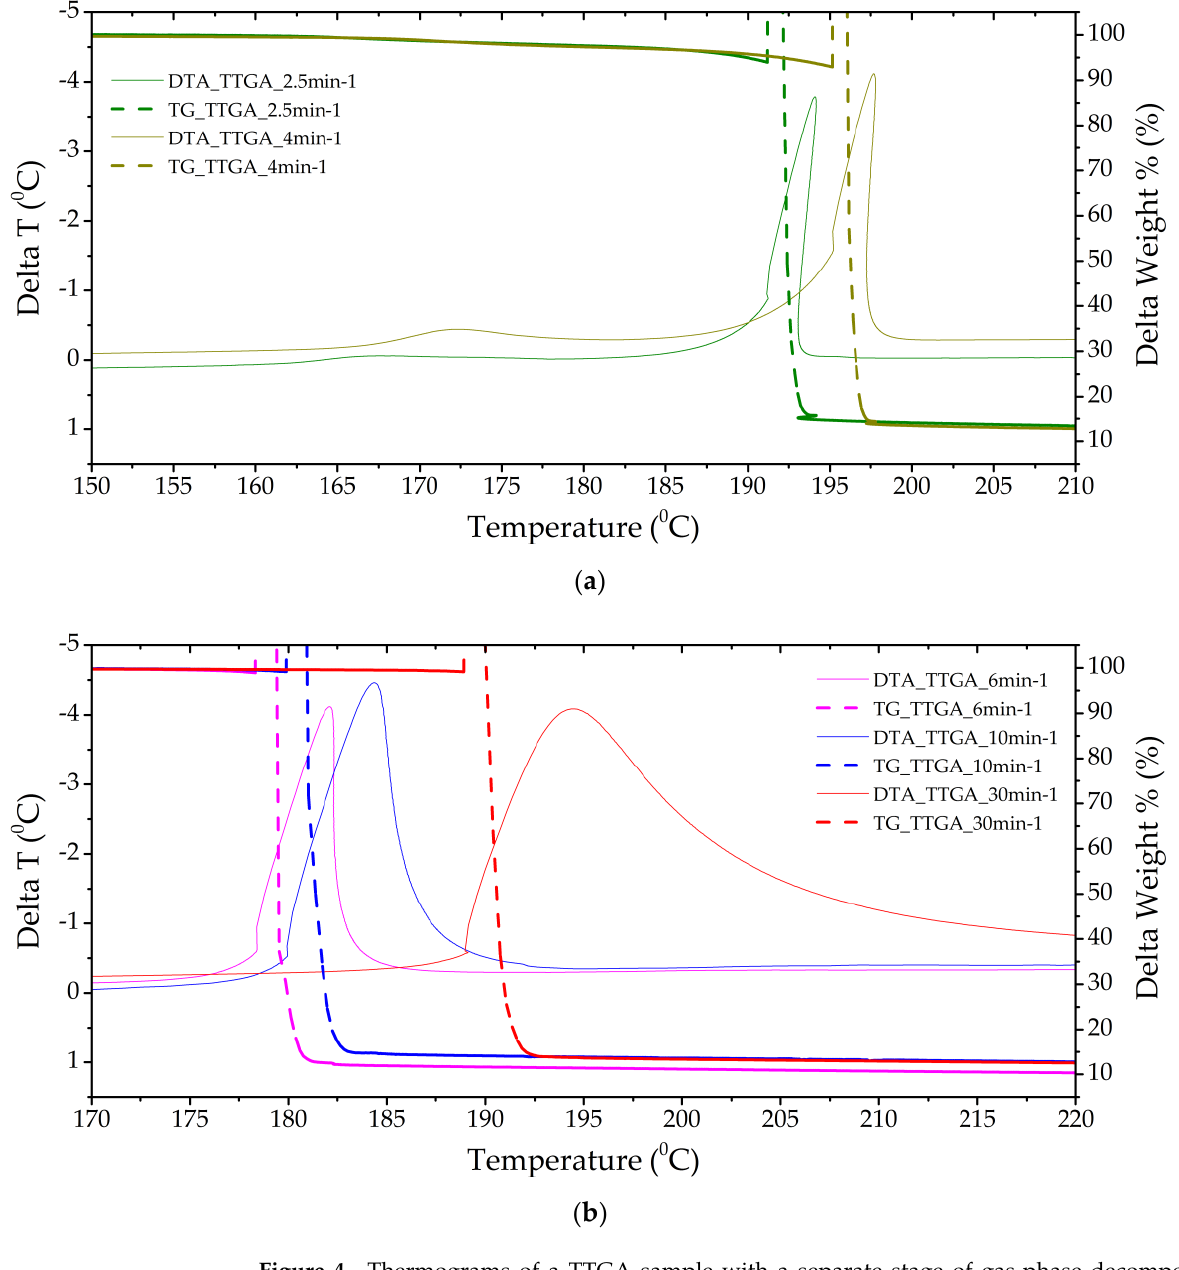
Figure 4. Thermograms of a TTGA sample with a separate stage of gas-phase decomposition ( a ) (heating rates of 2.5 and 4 min −1 ) and solid-phase decomposition with gas-phase assistance ( b ) (heating rates of 6, 10 and 30 min −1 ).